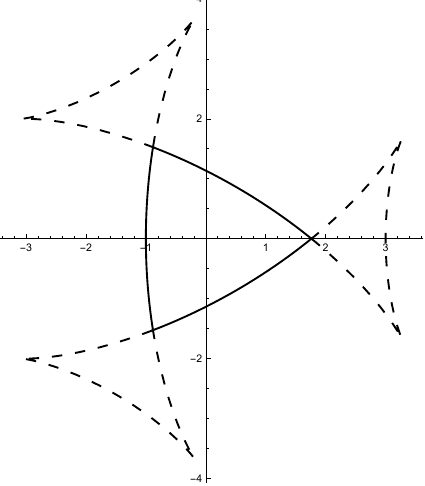
Figure 2. The image of the Cahn–Hoffman map ξ γ for γ in Example 4: The six vertices are the image of the singular points of ξ γ , and the closed convex solid curve is the Wulff shape W γ